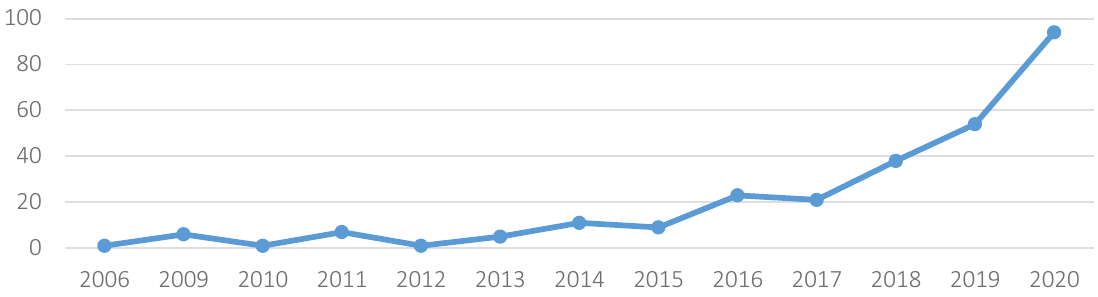
Figure 2. Sustainable HRM research publications per year